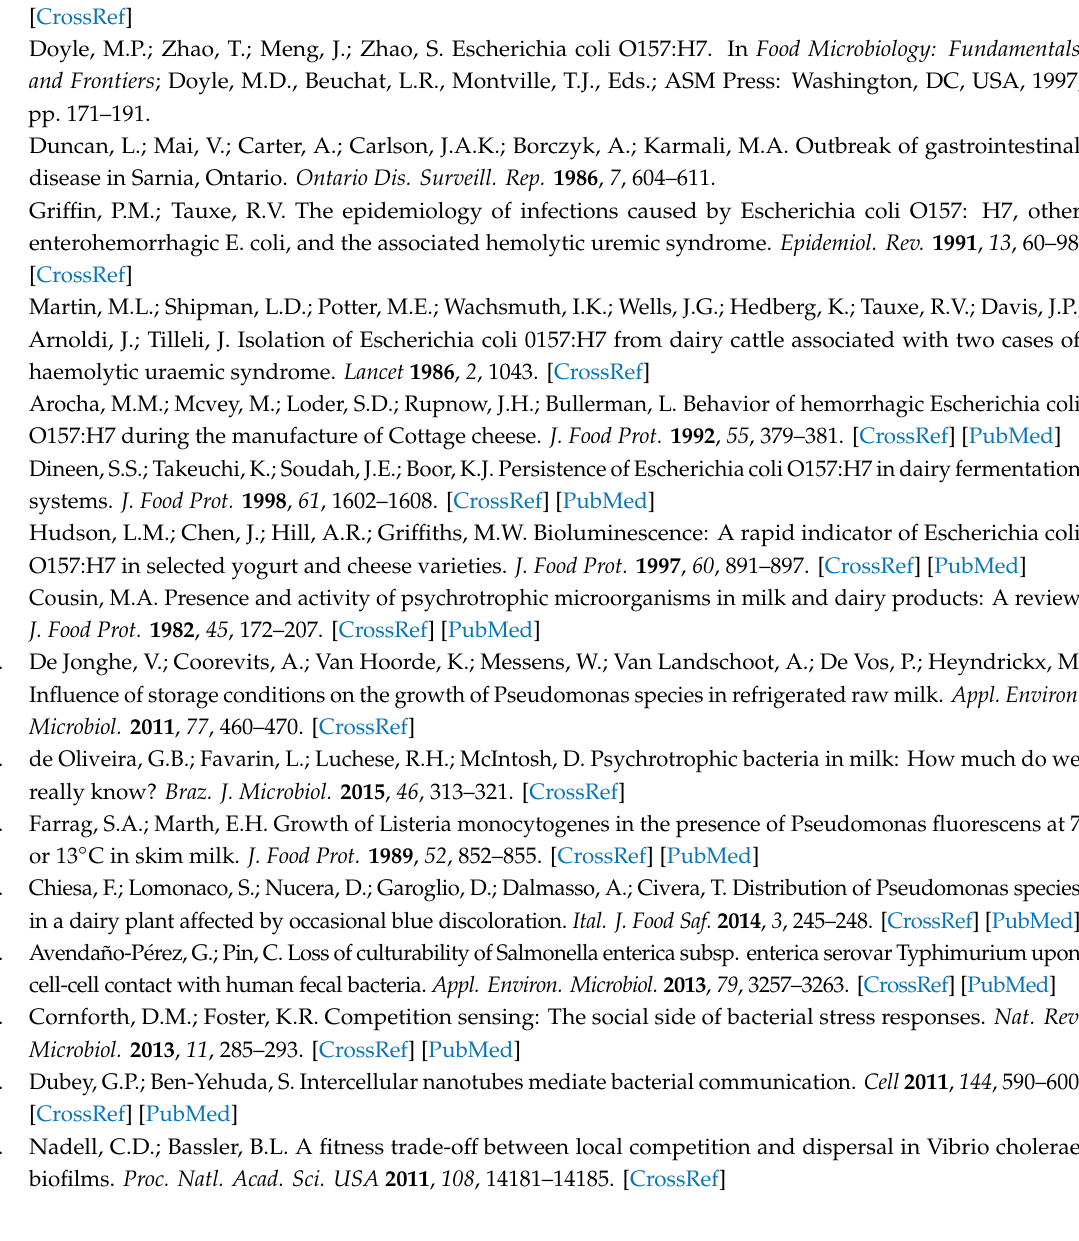
legends and explanations in Figure S1. Figure S4 : Hamiltonian Monte Carlo Method (HMCM) diagnosis plots of the decline rates of E. coli O157:H7 LCDC 86-51 (EcO1), E. coli O157:H7 ATCC 35150 (EcO2) or E. coli ATCC 8739 (Ec) co-cultured with P. fluorescens at 25 ◦ C. See legends and explanations in Figures S1 and